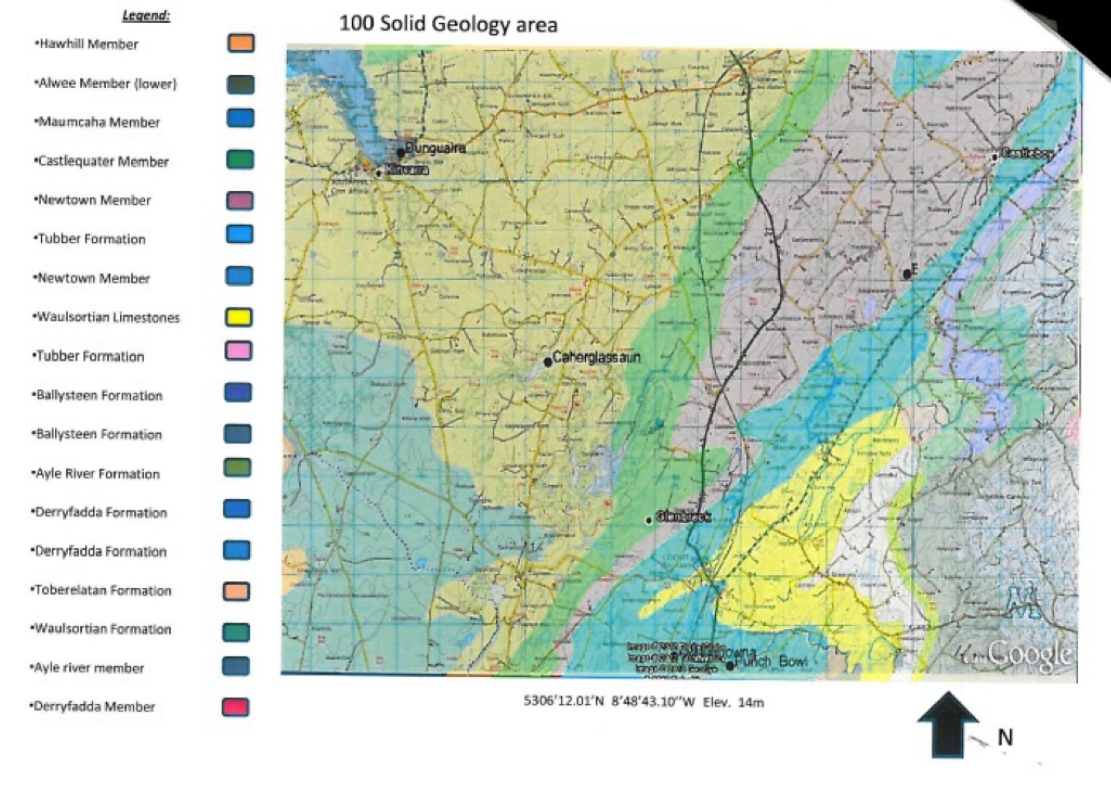
Figure 4: Sample of Student map produced with data from the GSI, the OS map given to them in class and the map legend from Microsoft PowerPoint. Note the Geology map is overlaying the OS road